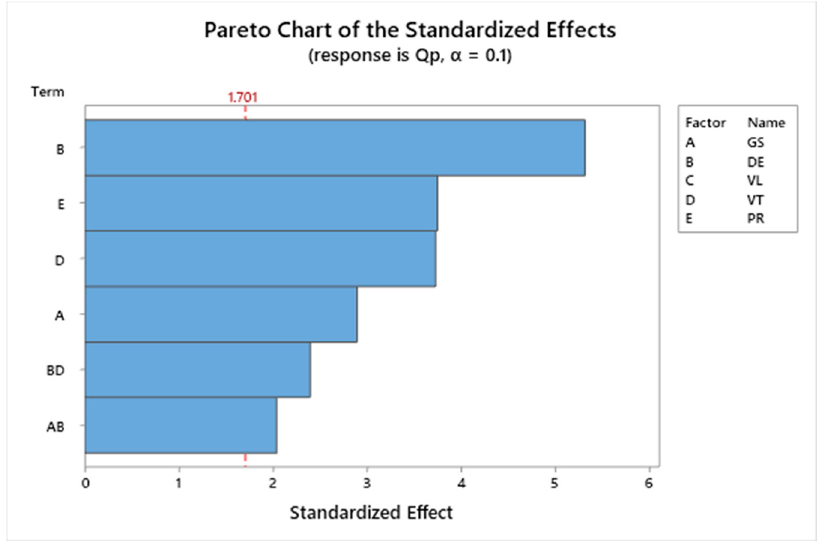
Figure 11. Pareto chart of the standardized effects for tool wear Qp.